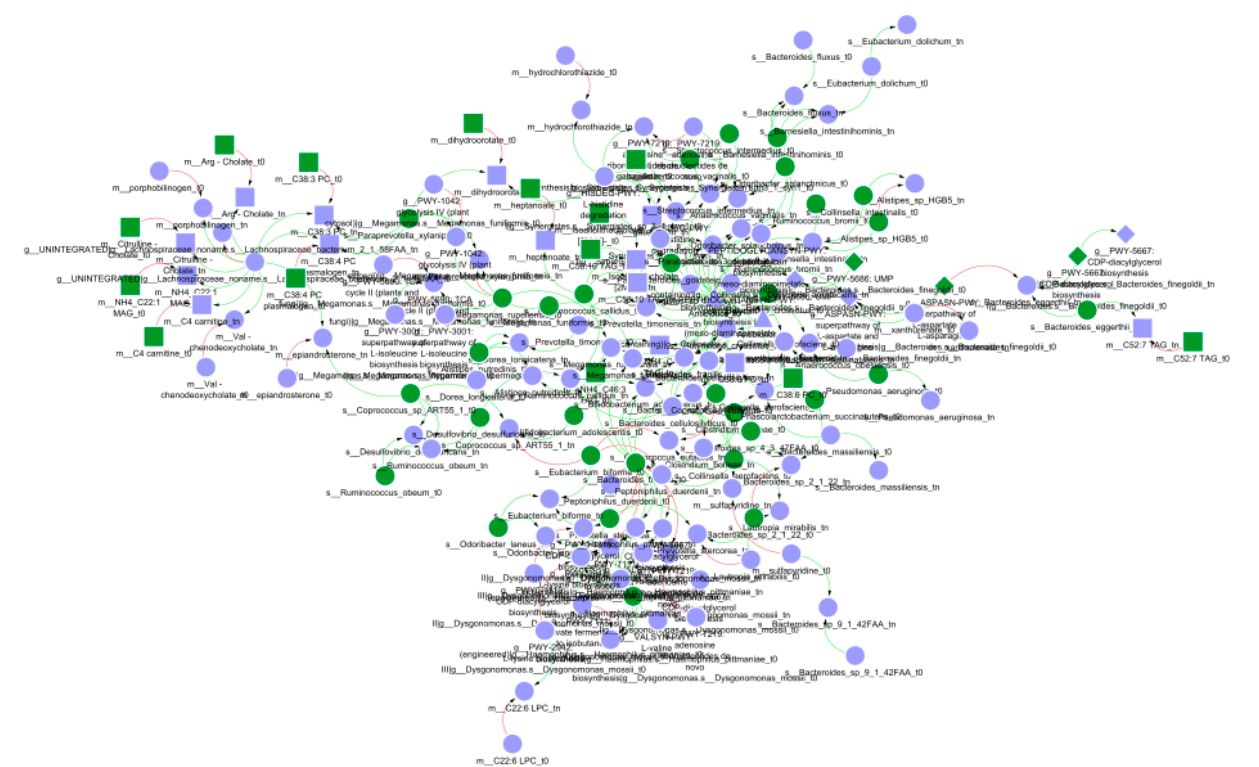
Figure 7. Learned DBN with ‘restriction matrix’ constraints on the top-50 best features per omic type. Green nodes represent time slice t i and purple nodes the consecutive t i +1. Metabolite nodes are represented by squares, species (taxa) by circles, clinical variables by triangles, and metabolic pathways by diamonds. The total number of nodes is 182, and the total number of edges is 231.